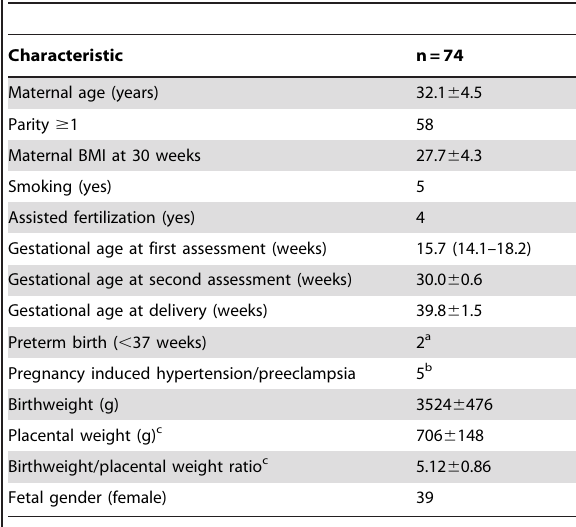
Table 1. Demographic characteristics and obstetric outcome data.